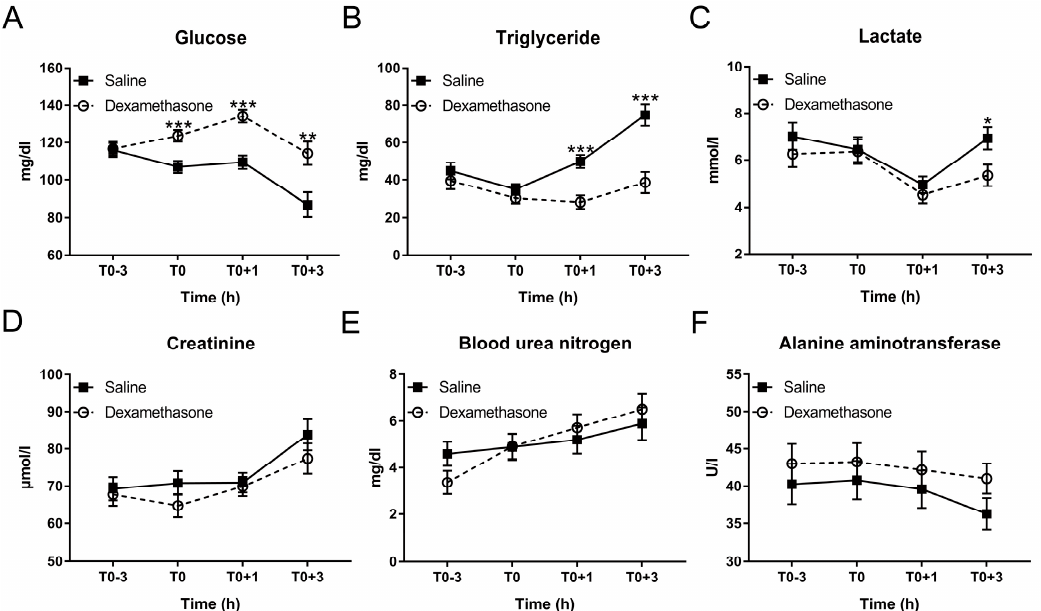
Figure 2. Effect of DEX on the kinetics of plasma biochemical parameters following LPS challenge. ( A ) Glucose; ( B ) triglyceride; ( C ) lactate; ( D ) creatinine; ( E ) blood urea nitrogen (BUN); and ( F ) alanine aminotransferase (ALT). Data are presented as least-squares means ± SE. * p < 0.05, ** p < 0.01, *** p < 0.001.